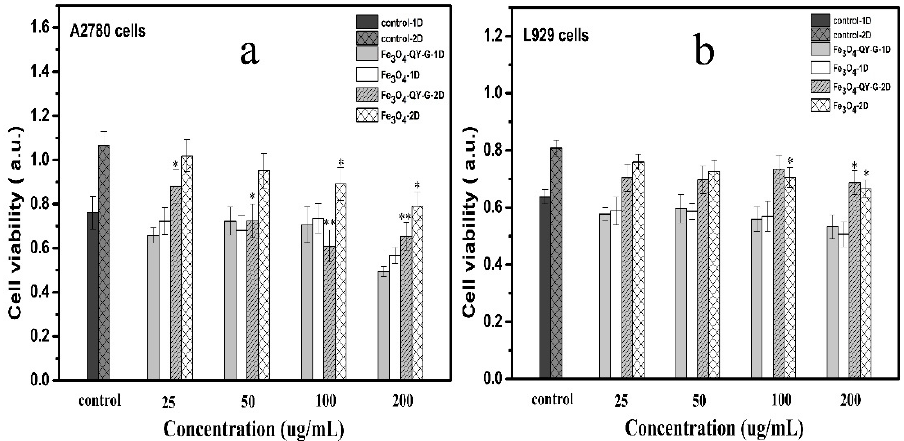
Figure 10. Effect of Fe 3 O 4 -QY-G and Fe 3 O 4 nanoparticles with different concentrations on the viability of ( a ) A2780 cells, ( b ) L929 cells. (* and ** show significant differences between groups treated with control and nanoparticles. * p < 0.05, ** p < 0.01. Data are presented as means ± SD, n = 6).